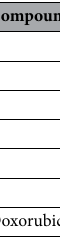
Table 1. The IC 50 values of compounds tested against SKOV-3 ovarian cancer cell line after 72 h incubation; 1 —positive control.